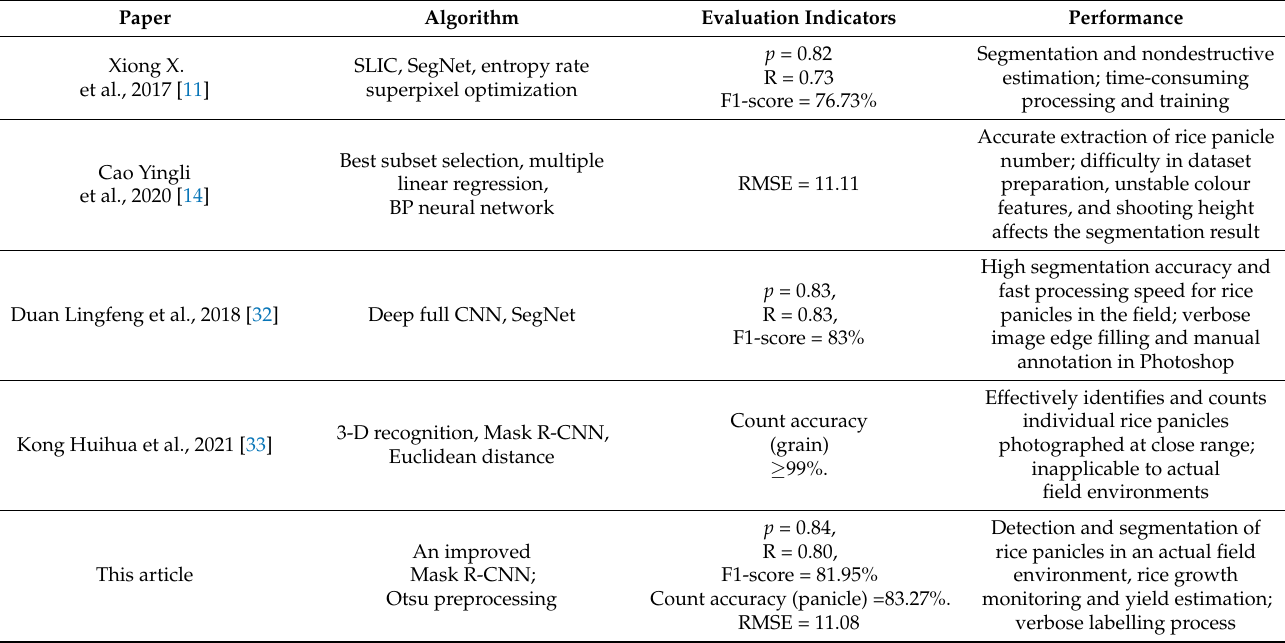
Table 4. Comparison between Panicle-Mask and other methods for rice panicle detection and